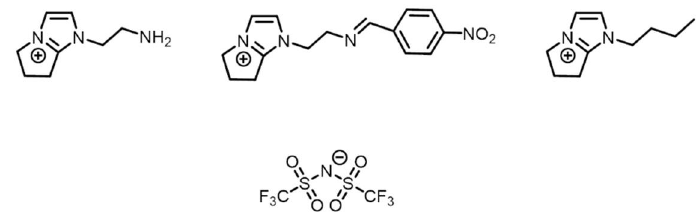
Figure 8. Ionic liquids for targeted VOC detections based on chemical reactions.